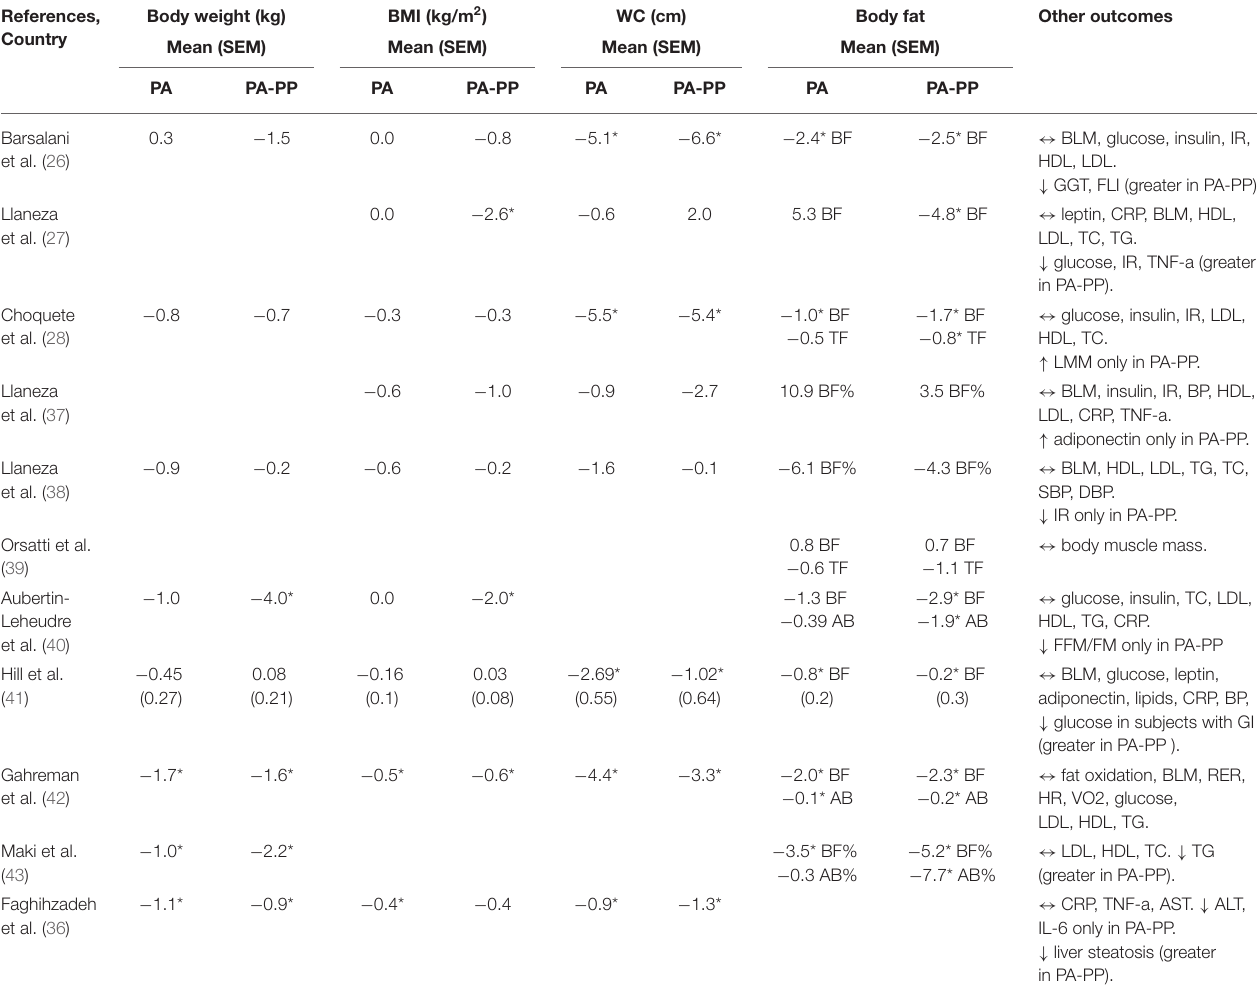
TABLE 4 | Changes of the outcomes after the intervention with physical activity programs and polyphenols. References, Body weight (kg) BMI (kg/m 2 ) WC (cm) Body fat Other outcomes Country Mean (SEM) Mean (SEM) Mean (SEM) Mean (SEM) PA-PP PA PA-PP PA PA-PP PA